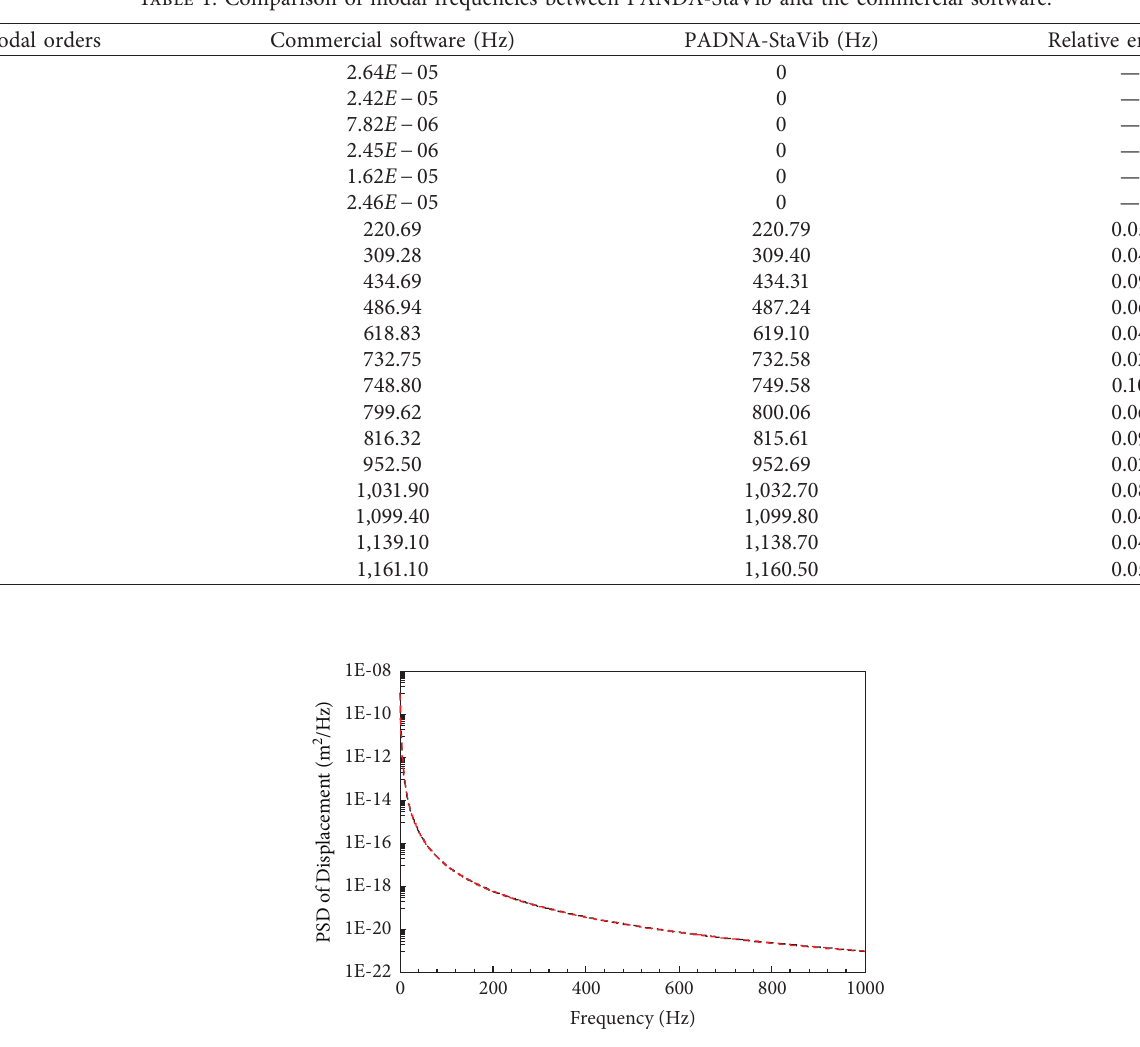
Figure 7: The PSD curves for excitation. Table 1: Comparison of modal frequencies between PANDA-StaVib and the commercial software.